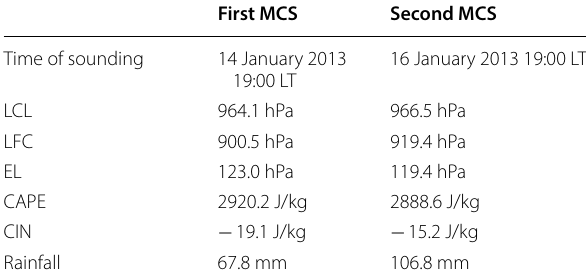
Table 3 Environmental CAPE and CIN ahead of both the first and the second MCSs obtained from Cengkareng, Soekarno Hatta International Airport sounding